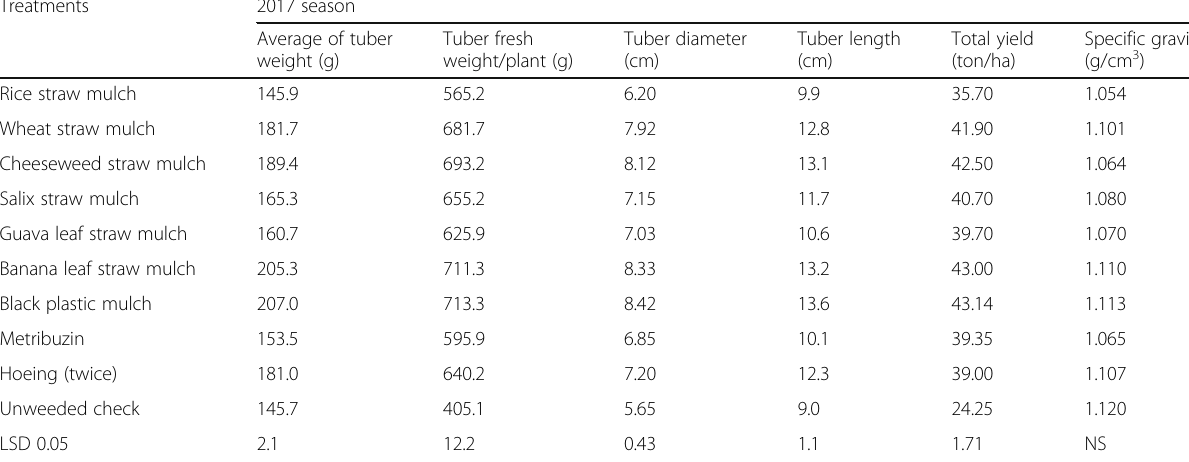
Table 4 Effect of different weed control treatments on yield traits of potato plants during 2017 season Treatments